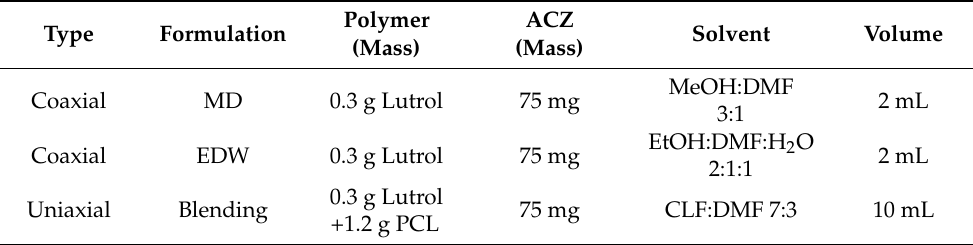
Table 1. Composition of the formulations used to produce the core of the coaxial fibers and the uniaxial fibers inner.